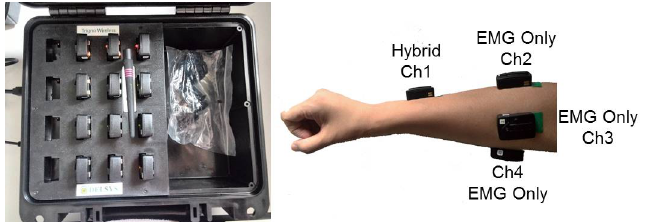
Figure 8. The positions of the ACC and sEMG sensors, as well as the ACC